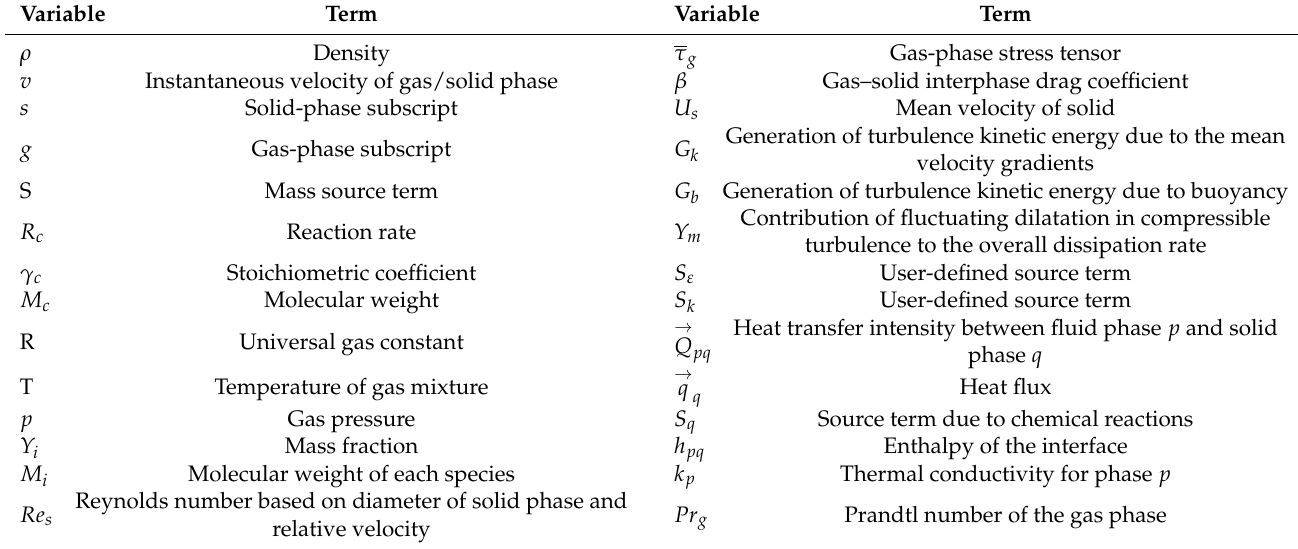
Table 8. Definitions for variables in Table